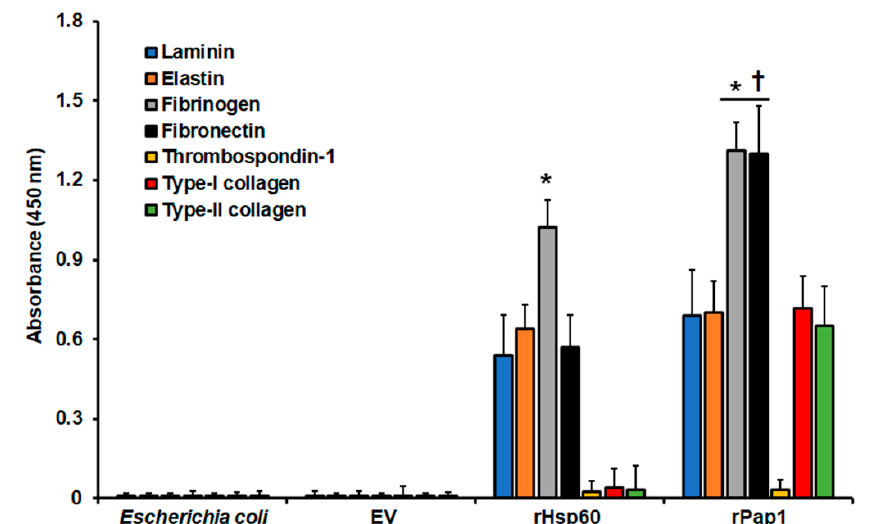
Figure 4. Adhesion of recombinant Hsp60 and Pap1 to immobilized extracellular matrix proteins. The extracellular matrix proteins were immobilized in 96-well plates and used in ELISA-based analyses. Cell homogenates from nontransformated bacteria ( Escherichia coli ) and bacteria transformed with the empty vector (EV) expressing rHsp60 (rHsp60) or rPap1 (rPap1) were incubated with the immobilized extracellular matrix proteins, and the protein–protein adhesion detected with the specific polyclonal anti-rHsp60 or anti-rPap1 and peroxidase-conjugated anti-rabbit IgG. Results are means ± SD of three independent experiments performed by duplicate. * p < 0.05 when compared to the other immobilized proteins. † p < 0.05 when compared to cell homogenates containing rHsp60.